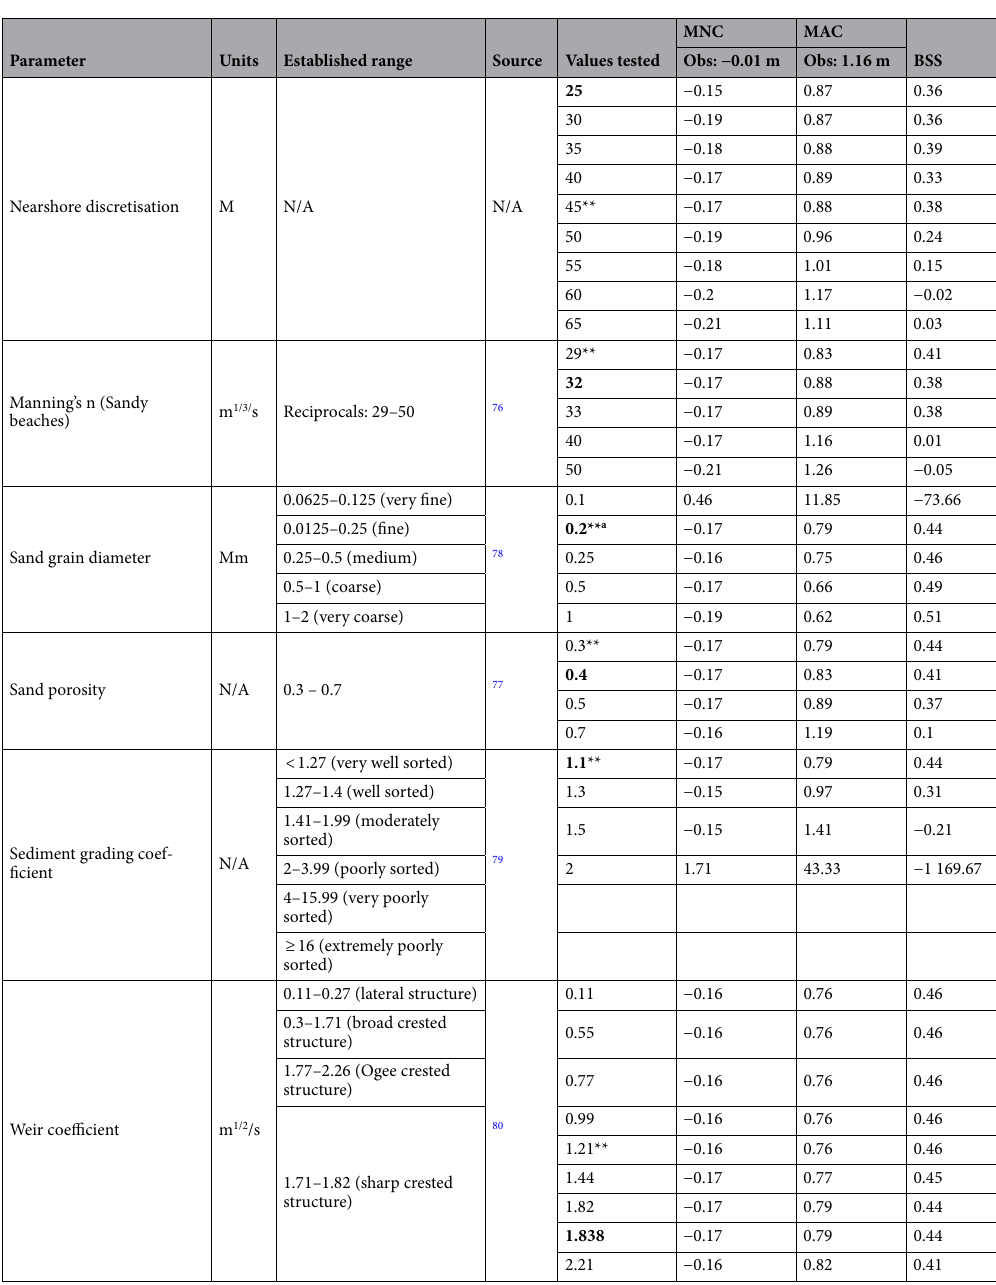
Table 5. Calibration parameters, inputs, and results. Bold values are the initial values. Values with two asterisks (**) are the values used after calibration. MNC is mean net shoreline change, MAC is mean absolute shoreline change, BSS is Brier Skill Score, Obs is observed. a 0.2 mm sand grain diameter selected as this is more representative of observed sand properties at the test